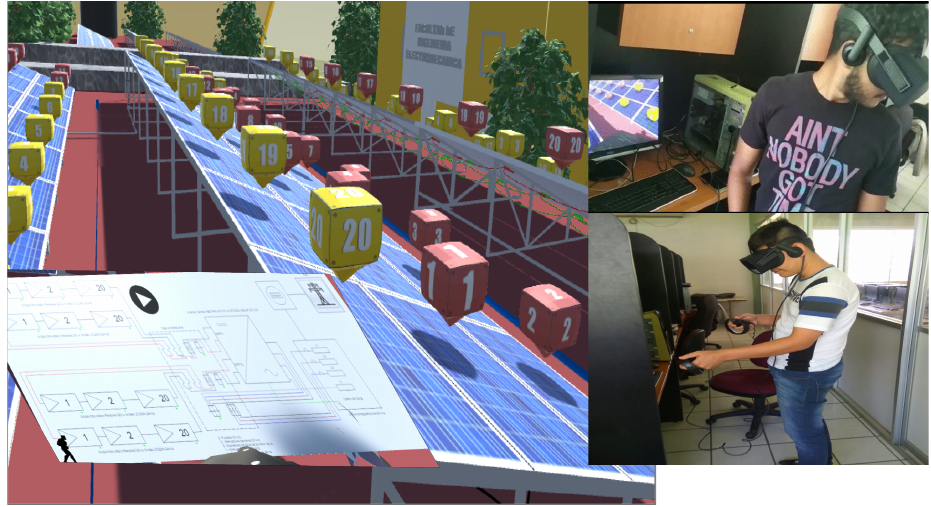
Figure 5. Supervising single line diagram for PV arrays connections.